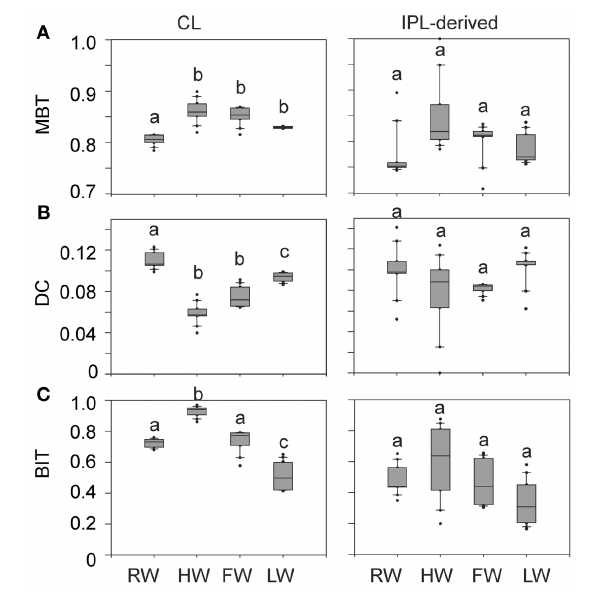
FIGURE 8 | Box plots of CL and IPL-derived MBT (A), DC (B), and BIT (C) in the Amazon main stem (Solimões and stations Amazon 1–4) at the four different seasons. Letters indicate statistically significant groups of data ( p < 0 . 05).